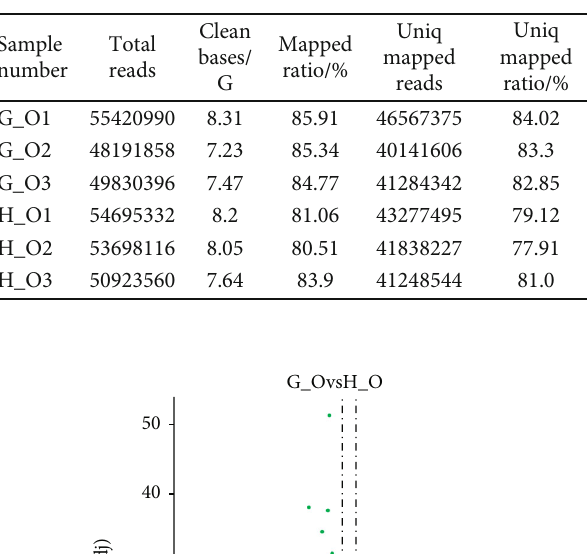
Table 3: Comparison results of clean reads and reference genomes.